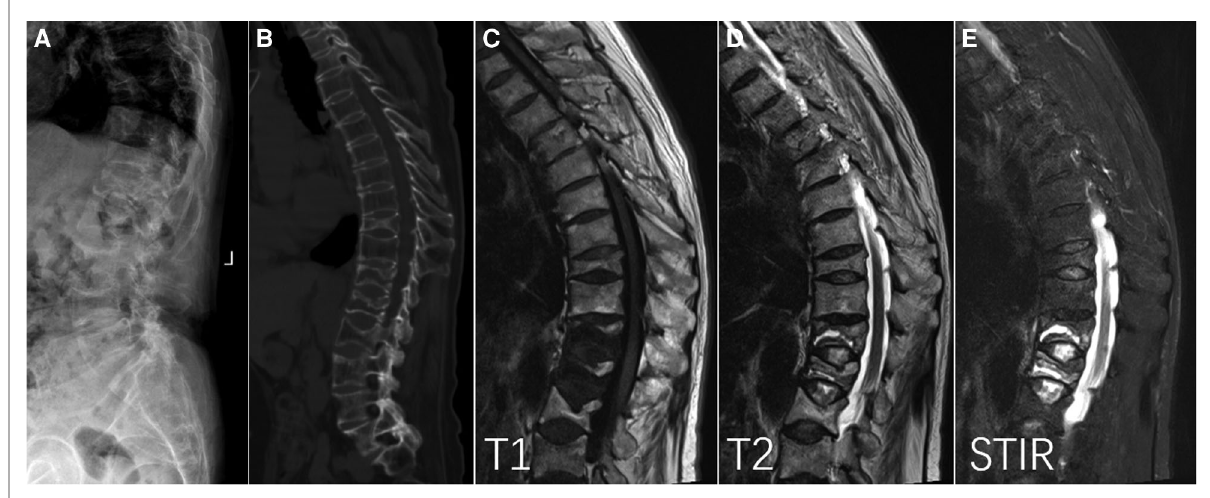
FIGURE 1 Intravertebral vacuum phenomenon (IVP) with vertebral fractures and ankylosing spondylitis. Lateral x-ray ( A ) and sagittal CT ( B ) showed low-intensity cleft throughout T12 and L1, characterized by well-de fi ned hypointensity on T1 ( C ), hyperintensity on T2 ( D ), and hyperintensity on short time inversion recovery ( E ).